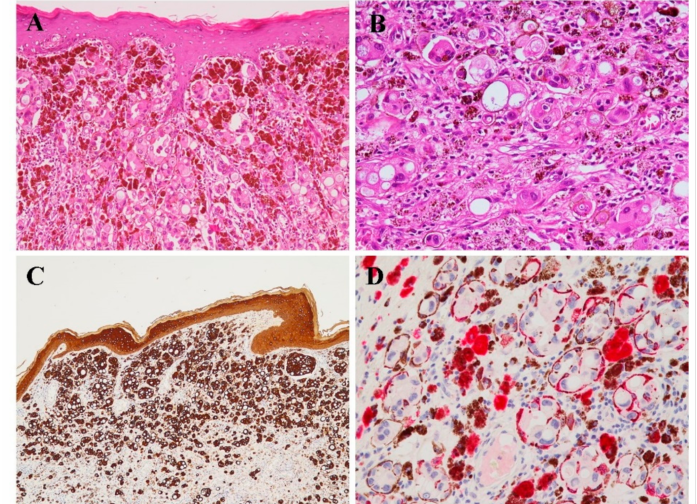
Figure 2. Histological and immunohistochemical features of case 2. ( A ) Low power view (4 × ) demonstrating a solid neoplastic proliferation with abundant pigment deposits, infiltrating the epidermis. ( B ) High power view (20 × ) demonstrating the epithelioid appearance of tumor cells showing abundant eosinophilic cytoplasm’s, intermixed with melanin with melanin pigment deposits. ( C ) The neoplasm showed a nevoid appearance with abundant melanin surrounding neoplastic cells with epithelioid morphology. ( D ) By immunohistochemistry, neoplastic cells showed diffuse immunoreactivity for cytokeratin AE1-AE3. HMB 45 staining highlighted only the surrounding melanocytes, while negative staining was observed in tumor